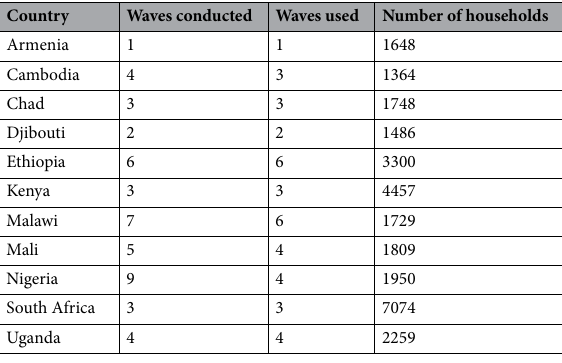
Table 1. Countries and